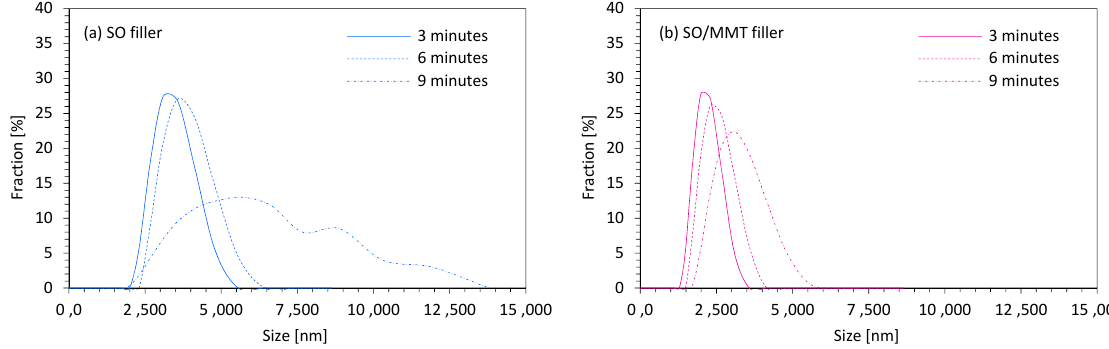
Figure 3. The particle size distribution of ( a ) SO filler, and ( b ) MMT-modified SO filler.